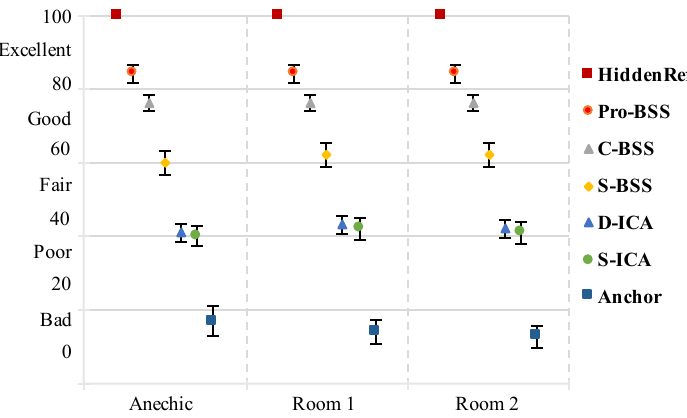
Figure 17. MUSHRA test results. Error bars with 95% confidence